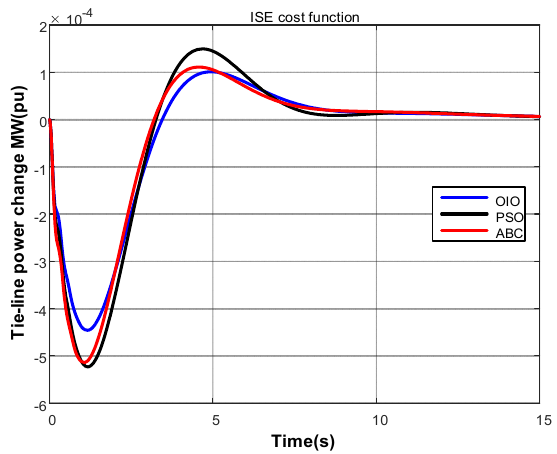
Figure 12. Change in tie ‐ line power for IAE.